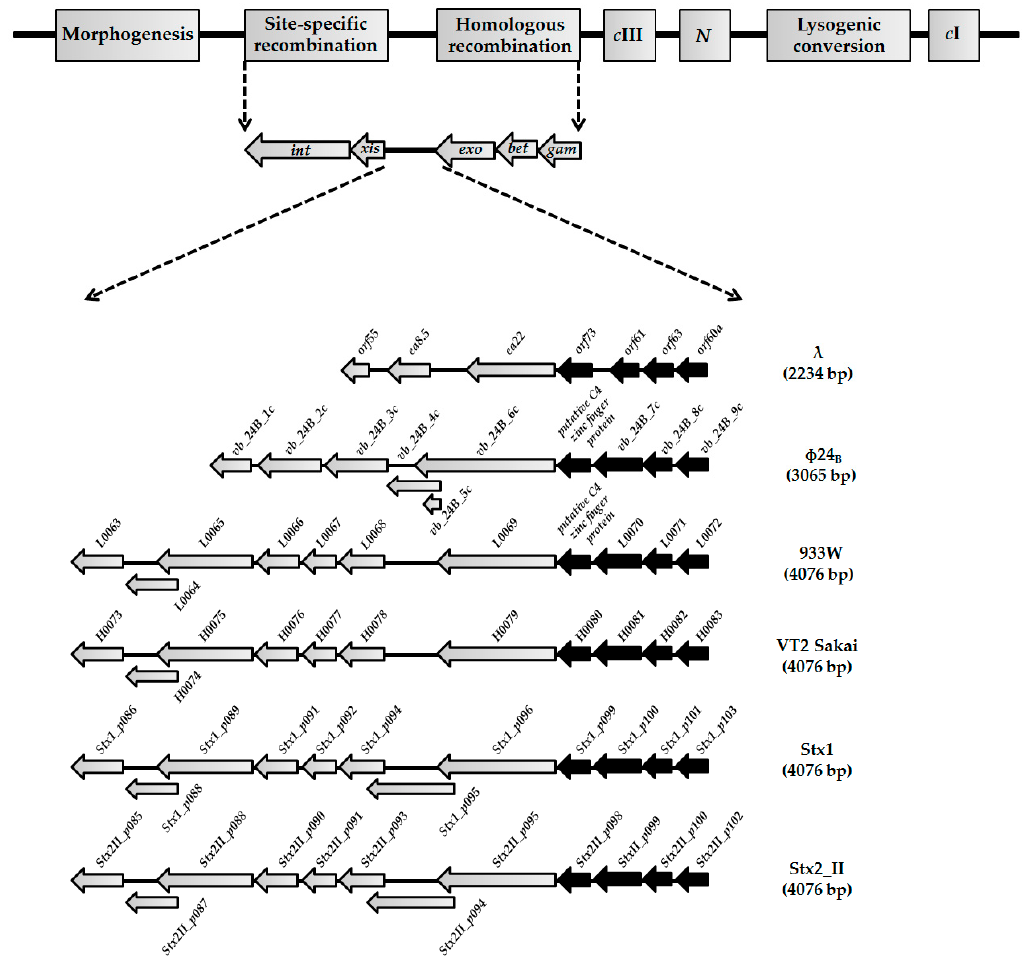
Figure 1. Genes and open reading frames (ORFs) located between exo and xis genes in genomes of lambdoid bacteriophages: λ (NC_001416), Φ 24 B (HM208303), 933W (NC_000924), VT2 Sakai (AP000422), Stx1 (NC_004913), and Stx2_II (NC_004914). Black arrows represent highly conserved orf60a – orf73 regions among lambdoid phages ( ≥ 70% nucleotide sequence identity). Grey arrows with black borders present genes and ORFs with lower level of identity (<35%) or additional ORFs that occur in the exo-xis regions of Stx bacteriophages.